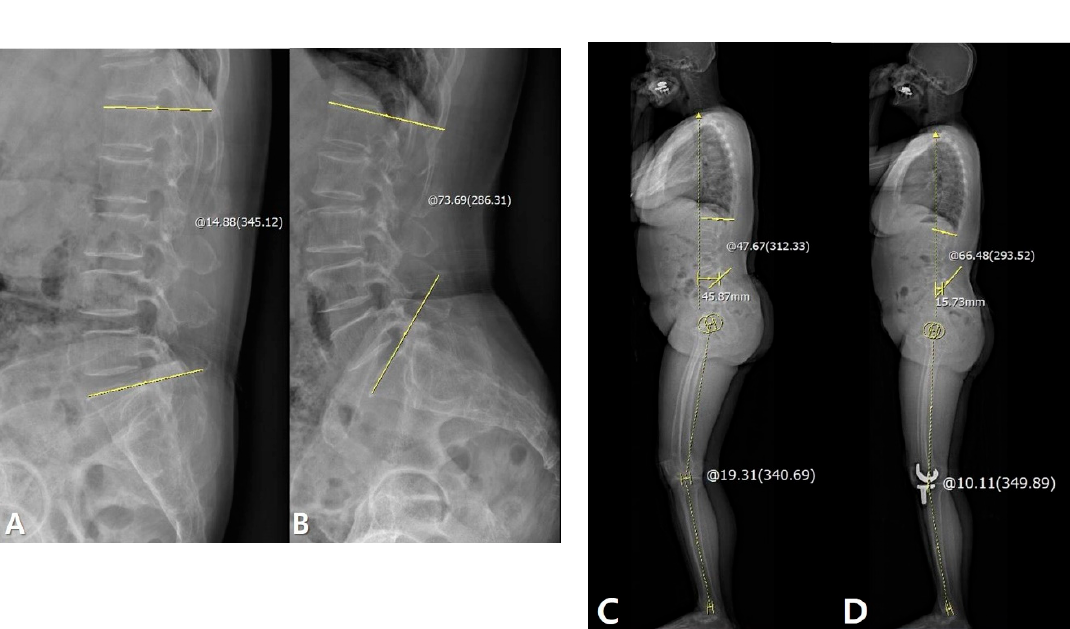
Independent Variable